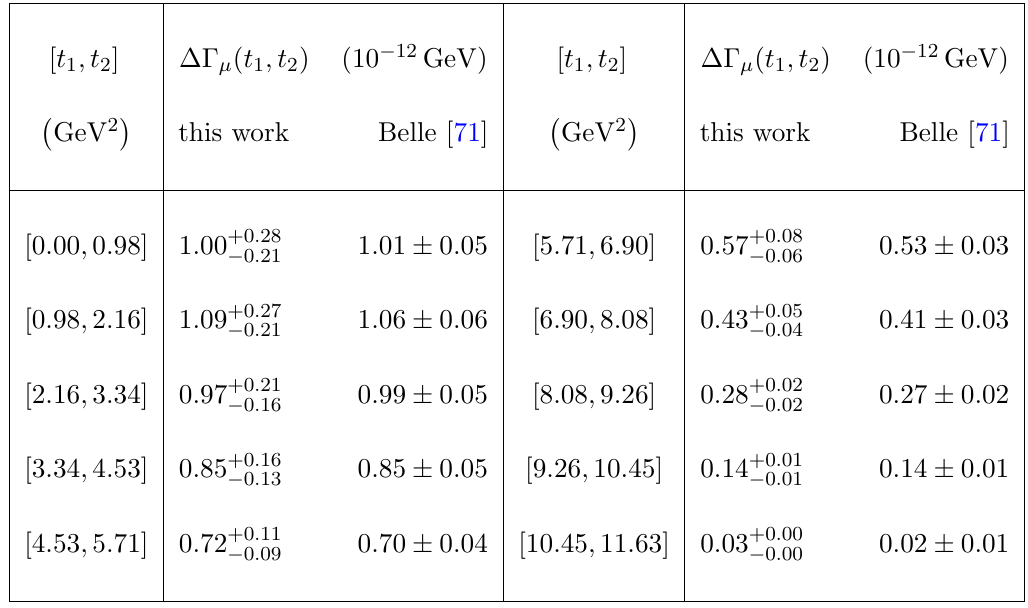
Table 2 . Theory predictions for the partial decay rates of B ! D(cid:22)(cid:23) (cid:22) compared with the Belle measurements from